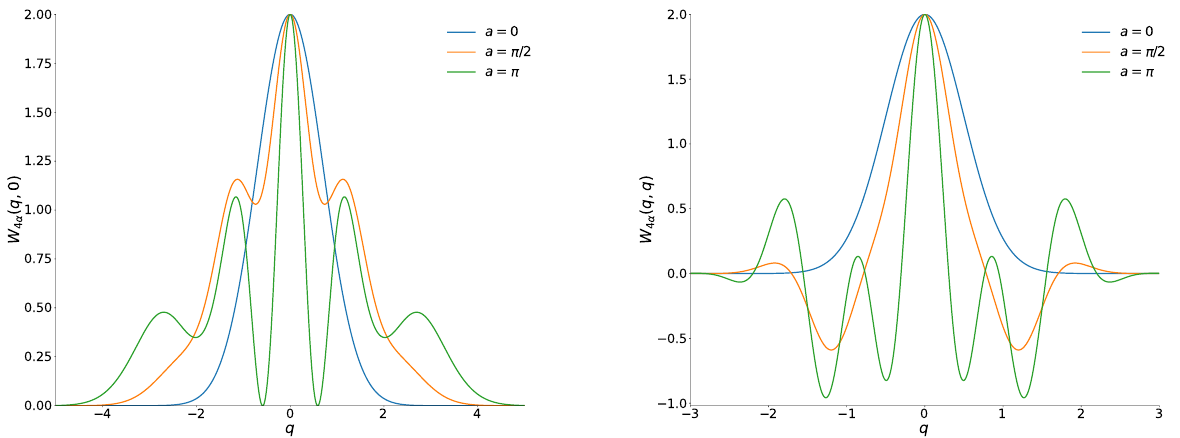
√ a . Left : W 4 α ( q ,0 ) . Right : W 4 α ( q , q )